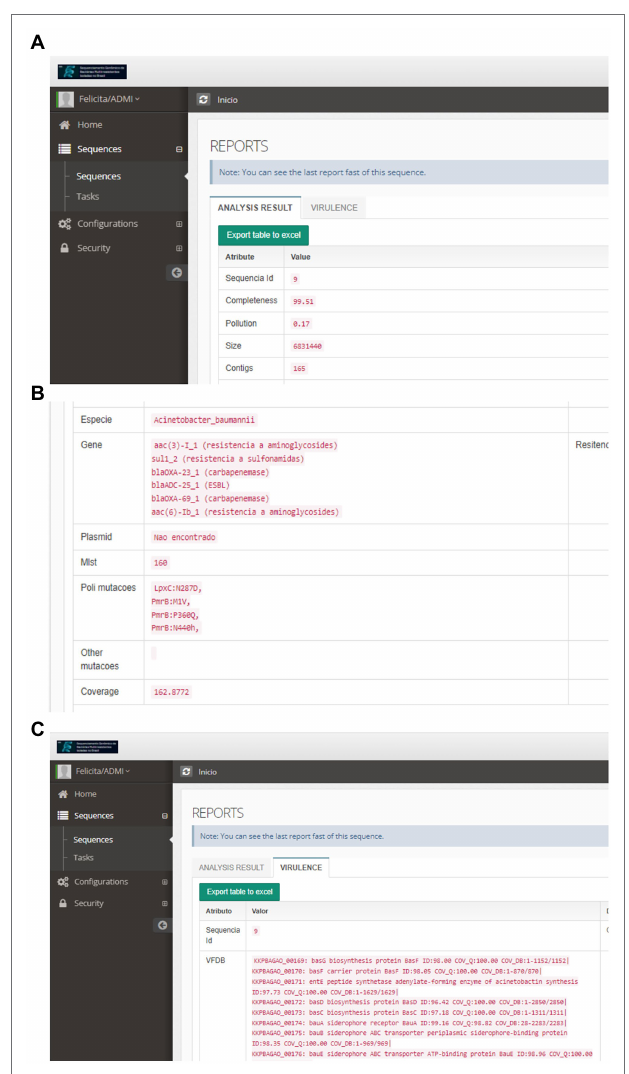
FIGURE 6 | Individual Report of the Result of the Bioinformatic Sequence Analysis: (A) Assembly Quality Control. (B) Genes Detected, Plasmids, MLST, and Mutations (C)